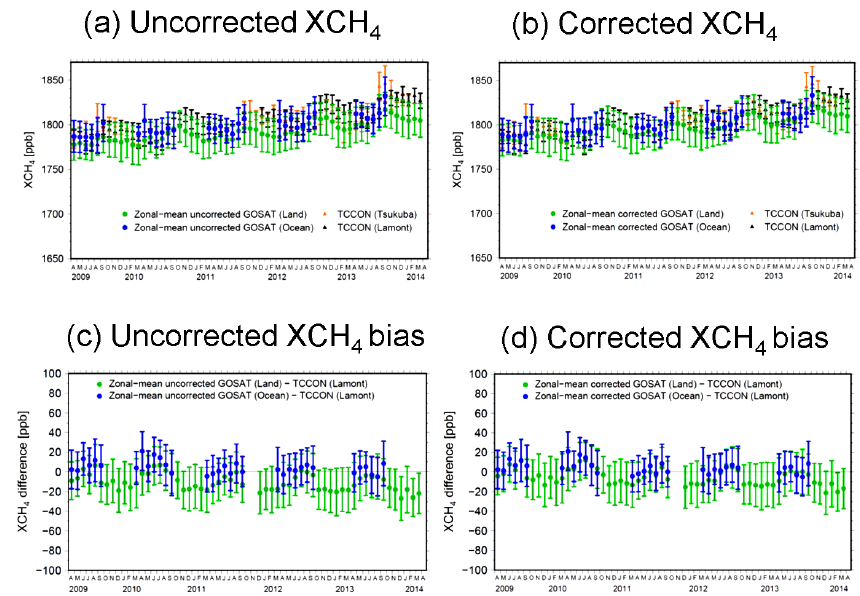
Figure 9. Temporal variations of (a) uncorrected and (b) corrected GOSAT XCH 4 and TCCON XCH 4 . Green and blue circles in (a) and (b) indicate the monthly zonal-mean GOSAT data retrieved over land and ocean regions within a 30 ◦ –45 ◦ N latitudinal band, respectively. The orange and black triangles in (a) and (b) denote the TCCON XCH 4 at Tsukuba and Lamont, respectively. Temporal variations of the differences between (c) uncorrected and (d) corrected GOSAT XCH 4 and TCCON XCH 4 at Lamont (GOSAT XCH 4 minus TCCON XCH 4 ) over land (green circles) and ocean (blue circles). See text for